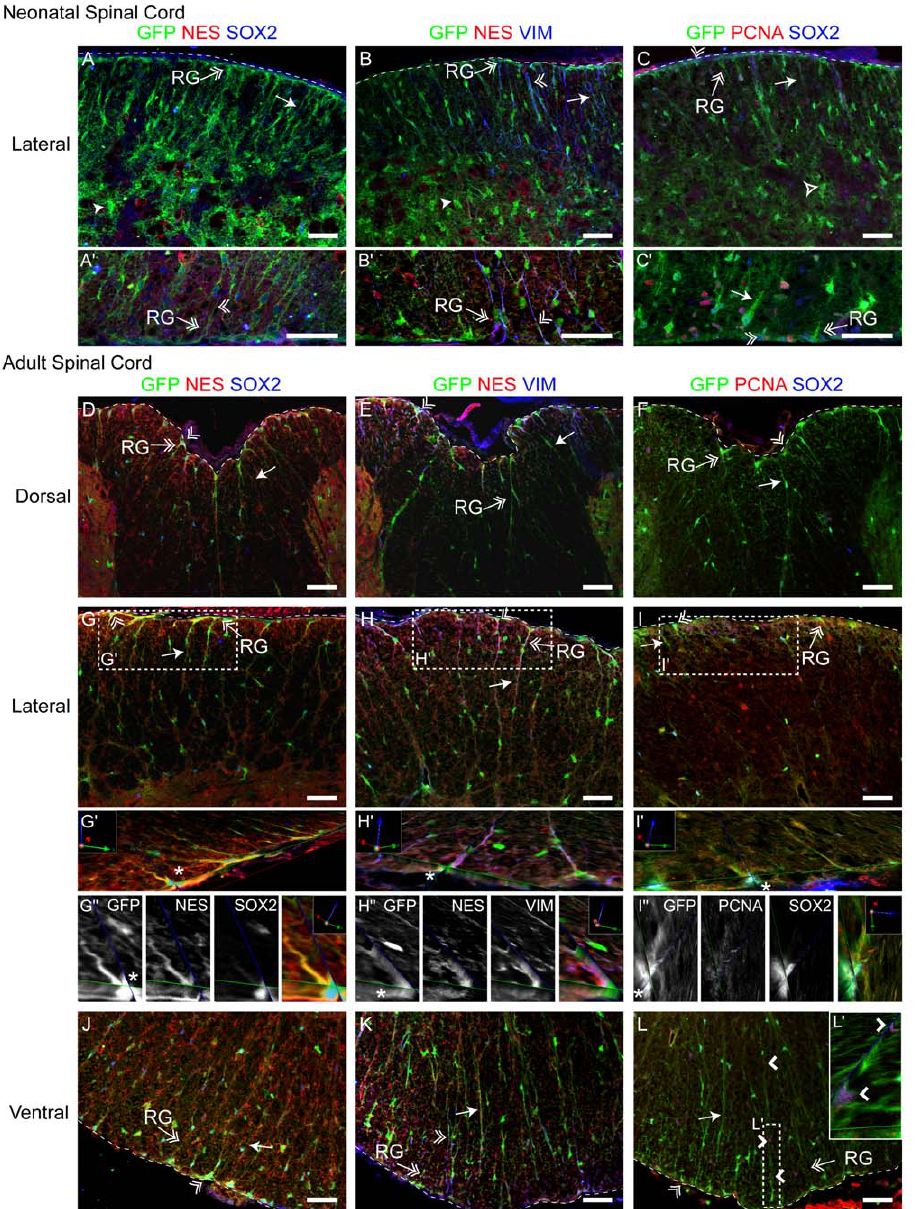
Figure 6. An Extensive Scaffold of Fabp7-EGFP-Expressing Spinal Cord Radial Glia Retain Progenitor-like Morphology and Gene Expression. (A–L) Confocal imaging of the SC of (A–C) neonatal (PND 5; cervical level) and (D–L) adult (P56; lumbar level) Fabp7-EGFP mice has allowed us to reveal a more extensive population of SCRG than detected by immunofluorescence (A–C) BLBP + (green) SCRG processes (arrows) begin at the marginal edge of the SC and extend throughout the WM and up to the astrocyte-rich (arrowhead) GM. Subpopulations of GFP + SCRG co- express (A, C) SOX2 (blue) and (B) VIM robustly (blue) but rarely (A, B) NES (red). Many nuclei contain (C) PCNA (red). (D–L) Although less abundant than in the neonatal SC, the (D–L) GFP + (green) processes of adult SCRG also demonstrate enhanced expression of (E, H, K) VIM (blue) and (D, E, G, H, J, K) NES (red). Their nuclei remain at the sub-pial edge of SC and small subpopulations retain expression of (D, F, G, I, J, L) SOX2 (blue) and (F, I, L) PCNA (red). Boxed areas outline magnified regions (G 9 –I 9 , L 9 ) of the z-stack that were rotated and tilted on a 3D plane to best highlight the anchored cell soma and processes at the pial boundary. (G 0 –I 0 ) Gray scale images of a single SCRG cell (asterisk in G 9 –I 9 ). Arrowhead: astrocyte; arrow: process; double arrowhead: triple-positive cell; double arrow: SCRG; open arrowhead: cell on SCRG process; dotted line: marginal edge of SC; BV: blood vessels. Scale bars: 50 m m.